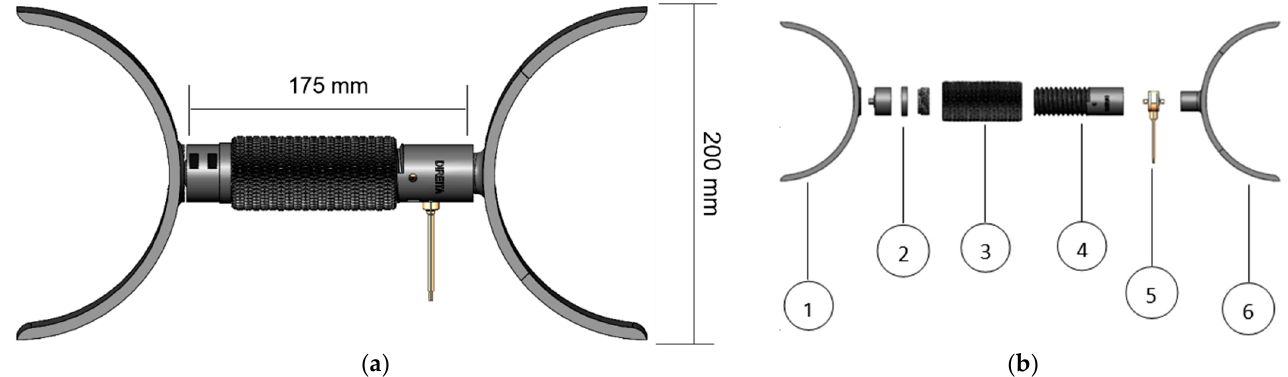
Figure 3. 3D model of the instrumented device for force measurement: ( a ) Global visualization; ( b ) Detail with components, (1)—fixed claw, (2)—fixed side element, (3)—central element, (4)—mobile side element, (5)—load cell, (6)—instrumented claw.